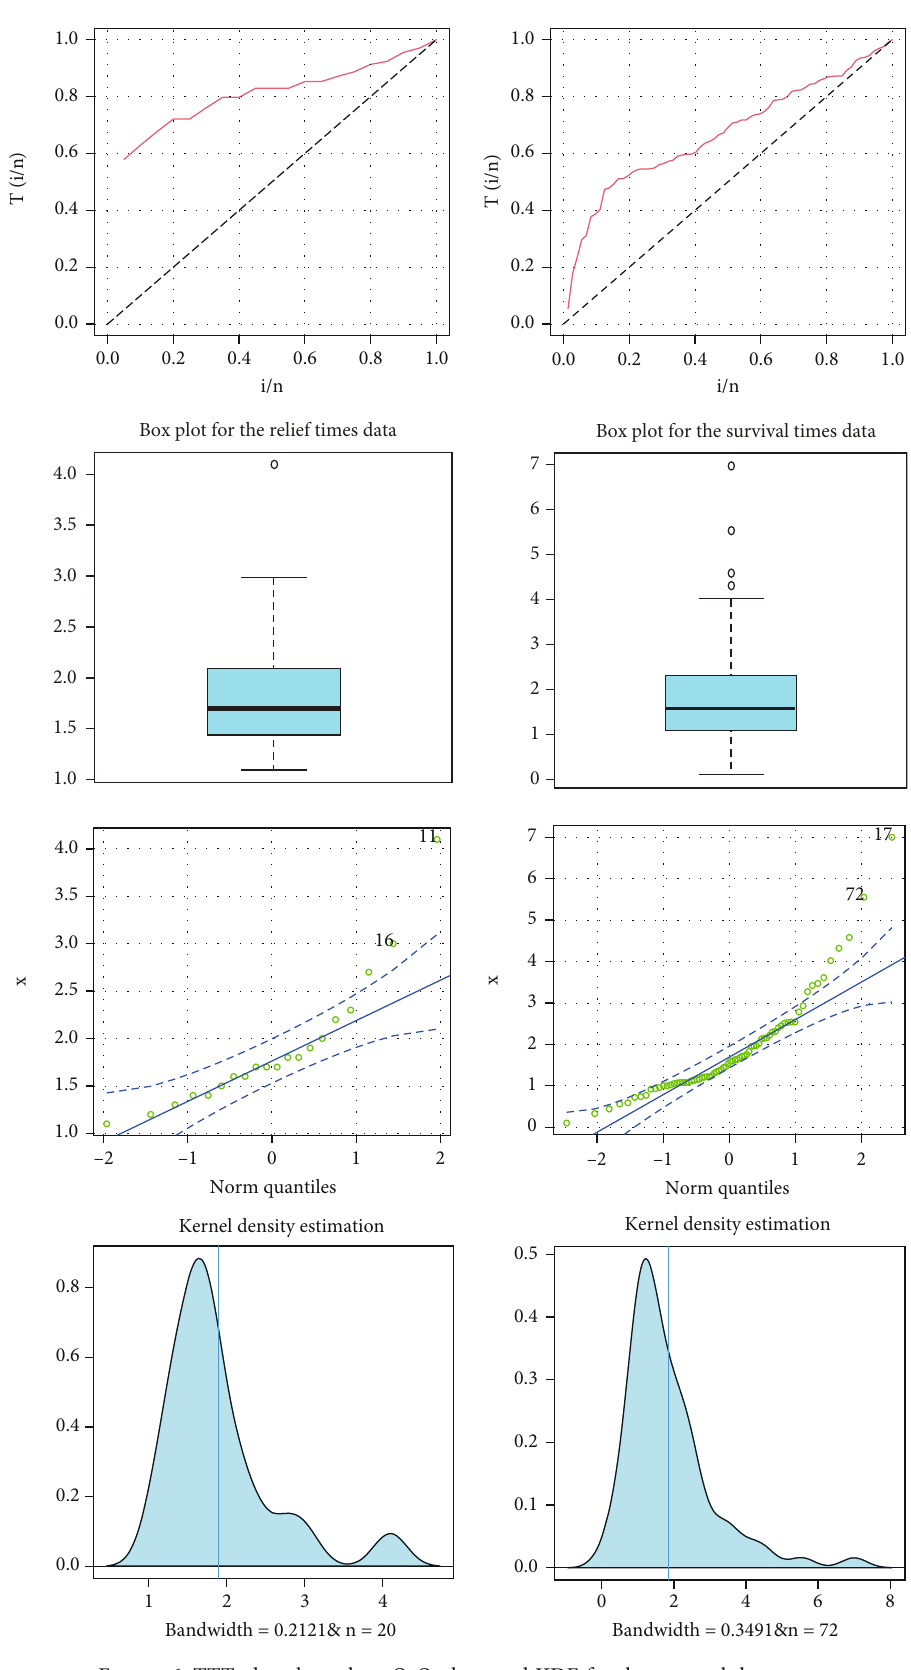
Figure 6: TTT plots, box plots, Q-Q plots, and KDE for the two real data